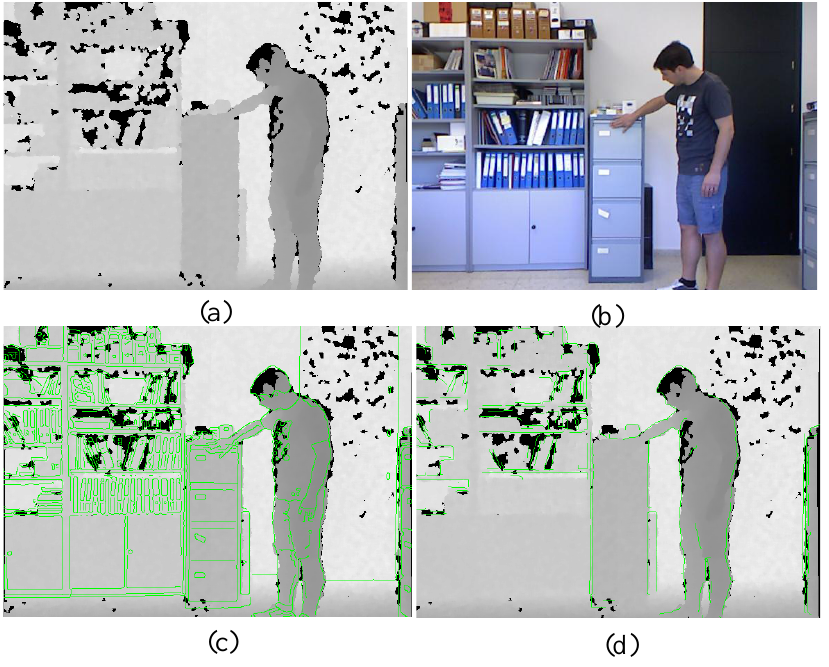
; ( d ) Overlaid image by D and I